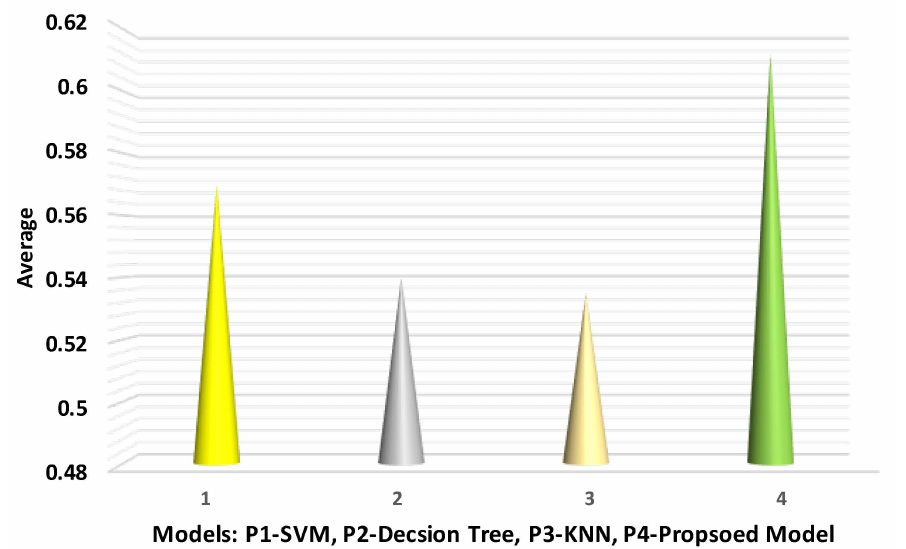
Figure 7. Average sensitivity analysis with different models.